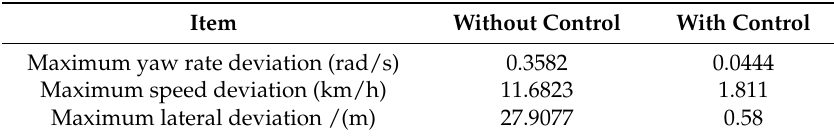
Table 8. Statistical control effect under F3 condition.